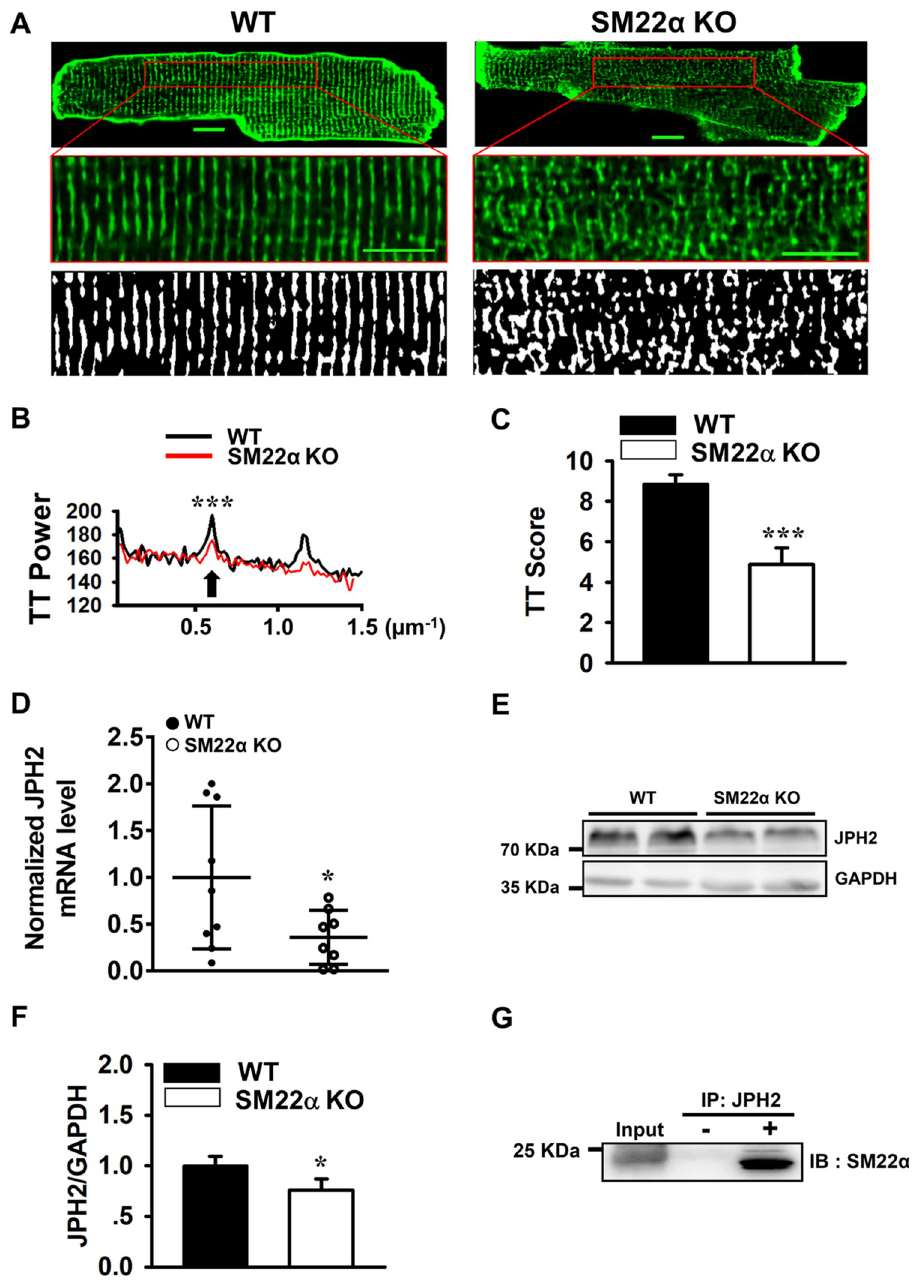
Fig 4. T-tubules are disrupted in SM22 α KO cardiomyocytes. (A) Confocal fluorescence images of representative di- 8-ANEPPS-stained single cardiomyocytes isolated from WT and SM22 α KO mice (upper). Respective high-resolution views and of areas within the red rectangles (middle). Corresponding Fast Fourier transformed images of T-tubule images (bottom). Scale bar = 10 μ m. (B) Representative power vs. spatial frequency along the x axis computed using Fourier analysis. (C) Bar graph showing TT score vs. WT control (n = 20 cells from 3 hearts in each group). (D) qRT-PCR analysis of JPH2 mRNA levels (WT: n = 9; KO: n = 8). (E) Western blot of JPH2 protein level in cardiomyocytes of WT and SM22 α KO mice. (F) Bar graph showed the mean ± SEM from 3 independent experiments (n = 4 per group). (G) Co-IP analysis for the interaction of SM22 α with JPH2. � P < 0.05, ��� P < 0.001 vs. WT control.